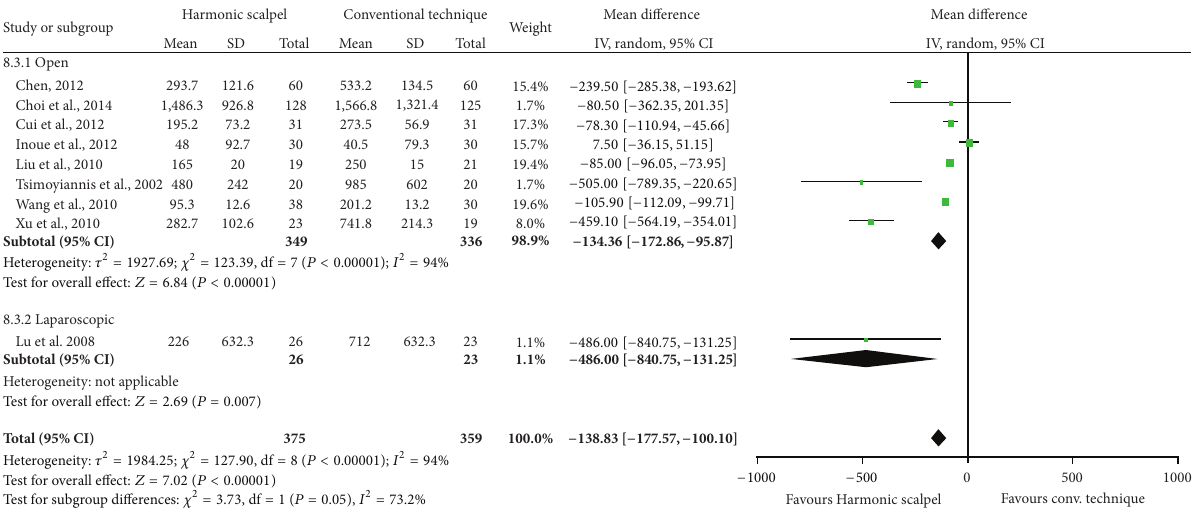
Figure 5: Forest plot of meta-analysis results for drainage volume (mL), stratified by open versus laparoscopic surgery.